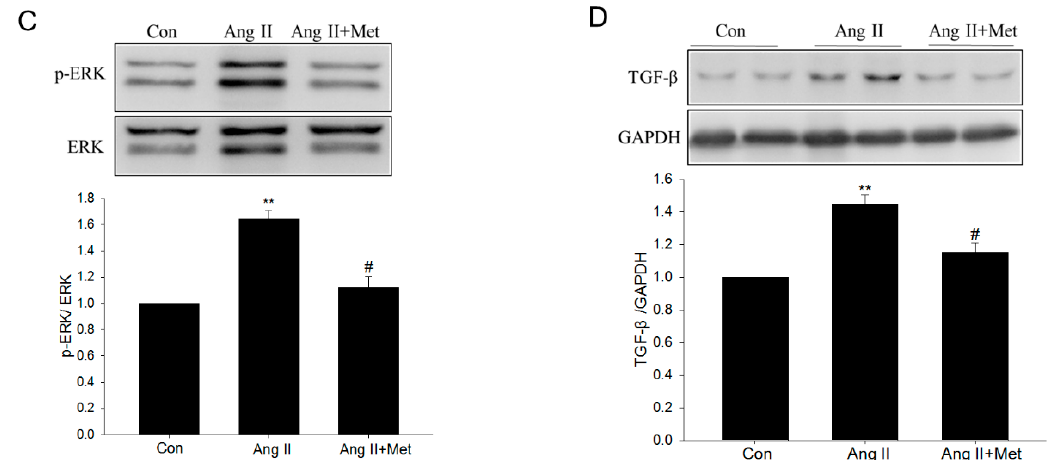
Figure 8. Effect of metformin on angiotensin II–induced transforming growth factor- β upregulation and ERK signaling activation. ( A , B ) Cells were treated with angiotensin II (Ang II) for the times indicated. The levels of transforming growth factor- β (TGF- β ) and p-ERK were analyzed by Western blotting; ( C , D ) TGF- β and p-ERK after metformin treatment, visualized by Western blotting. Data are the mean ± SEM of three experiments. * p < 0.05, ** p < 0.01 compared with control (Con); # p < 0.05 compared with Ang II only.